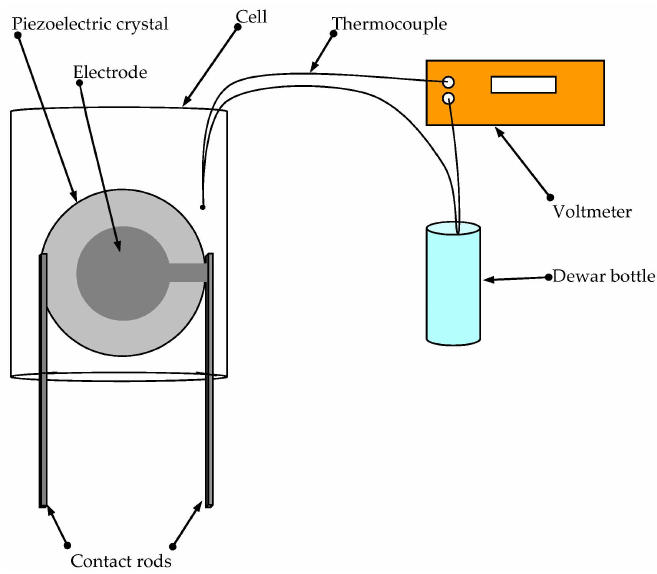
Figure 2. The experimental setup for carrying out the research with the suspensions.